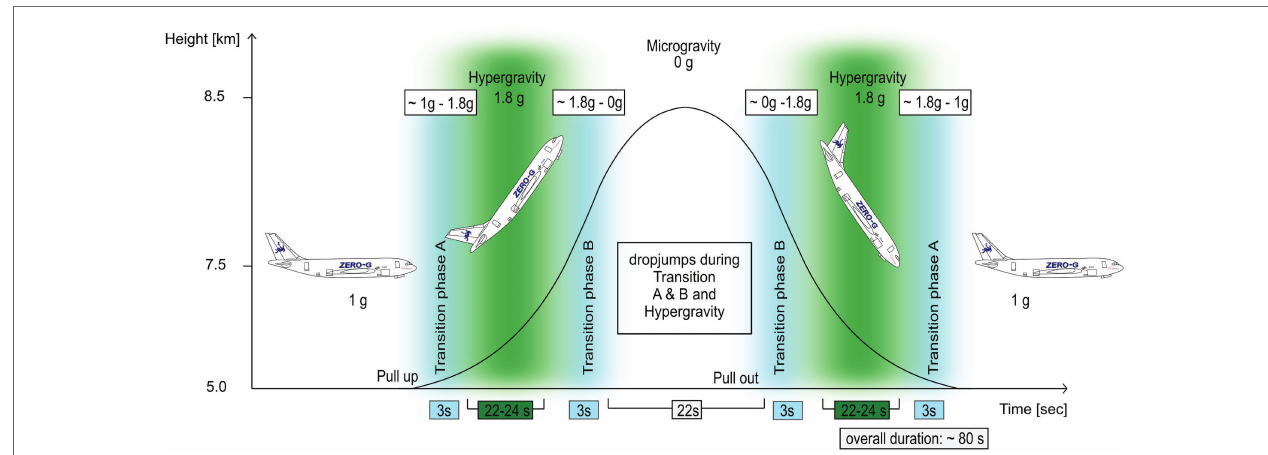
FIGURE 1 | The parabolic flight maneuver and the corresponding gravity levels: Each parabola starts with the airplane flying in “steady flight” condition (Earth’s gravity), followed by a hyper-gravity phase. When the aircraft reaches an angle of 50 ° , a free fall condition (zero gravity) is faced, after which a new hyper-gravity phase is experienced. The parabola ends with a new “steady-flight” phase. Jumps were performed during the hyper-gravity (green) and the transition phases A and B (blue); reference jumps were performed during 1 g. Adapted from Waldvogel et al.